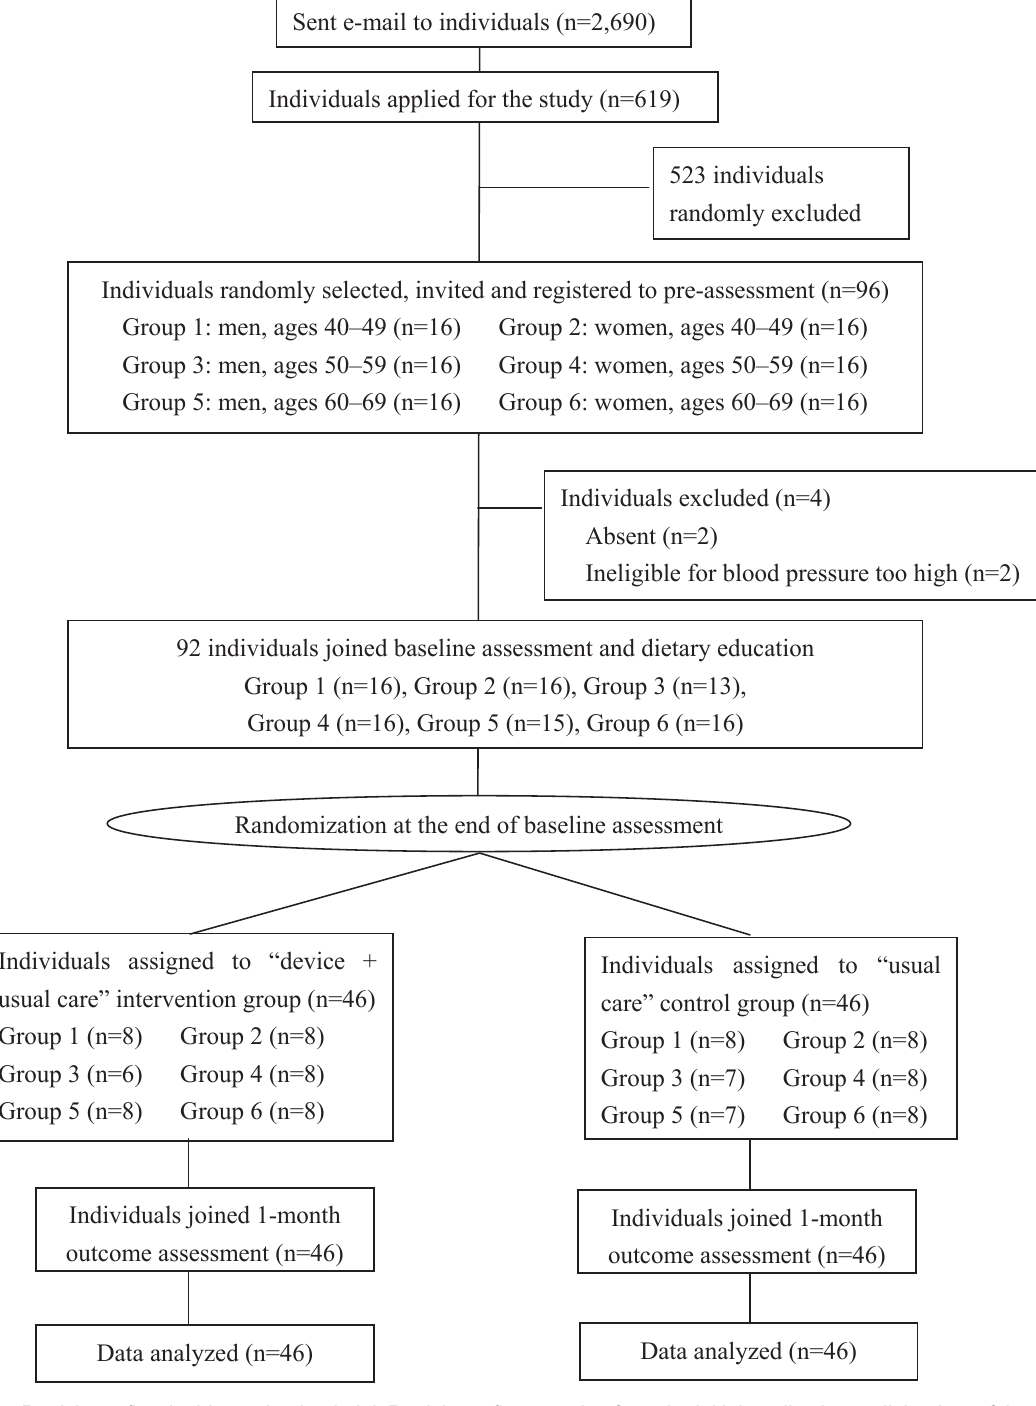
Figure 1. Participant fl ow in this randomized trial. Participant fl ow, starting from the initial application until the time of the 1-month outcome assessment, of this intervention trial. Participants initially received an email asking if they would like to take part in the intervention trial. After volunteering, the participants were fi rst registered and then participated in this randomized trial. The intervention lasted for approximately a